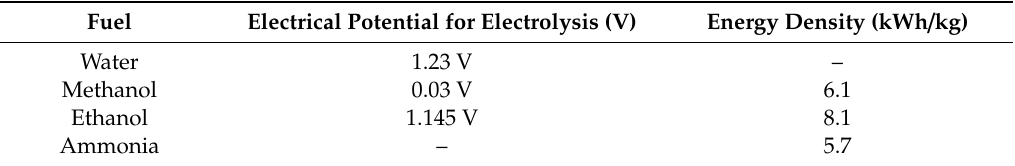
Table 1. Comparison of different energy parameters such as onset potential/efficient for different solvents to convert hydrogen.